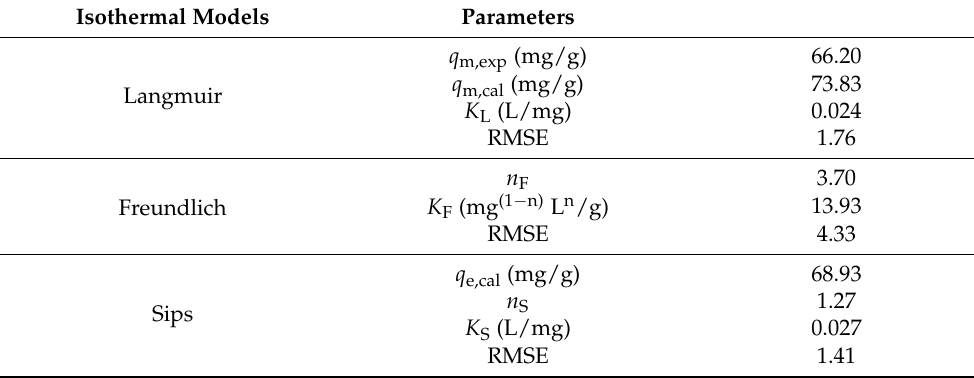
Table 2. Isothermal model constants, RMSE values and adsorption capacities of PYCS.